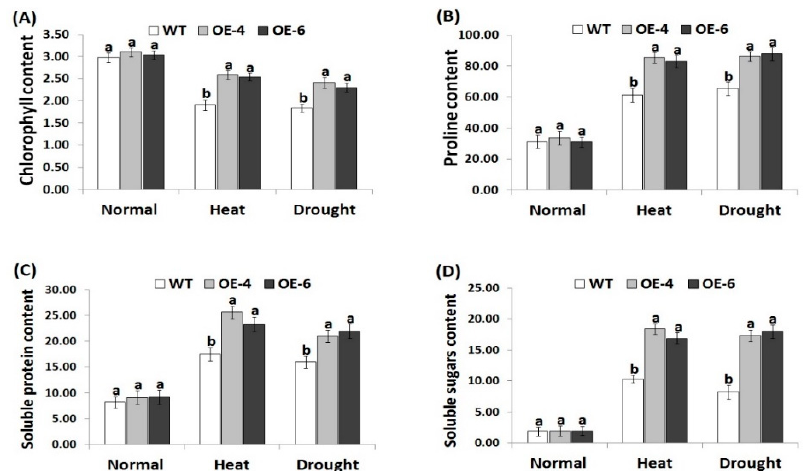
Figure 3. Contents of total chlorophyll (mg g − 1 FW) ( A ), proline ( μ g g -1 FW) ( B ), soluble proteins (mg g − 1 FW) ( C ), and soluble sugar (mg g − 1 FW) ( D ) of wild type and transgenic wheat lines under normal, heat, and drought stress treatments. Data indicate means ± SE ( n = 4). Different letters on the columns represent significant difference ( p ≤ 0.05).